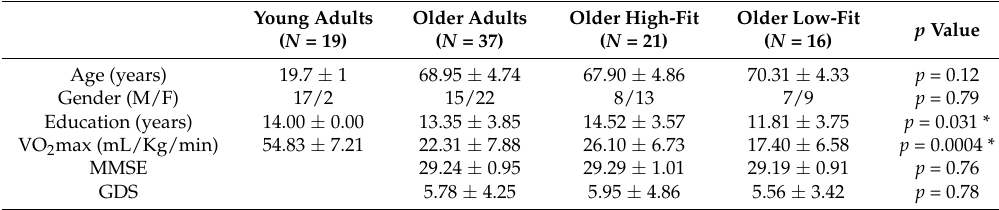
Table 1. Characteristics of the